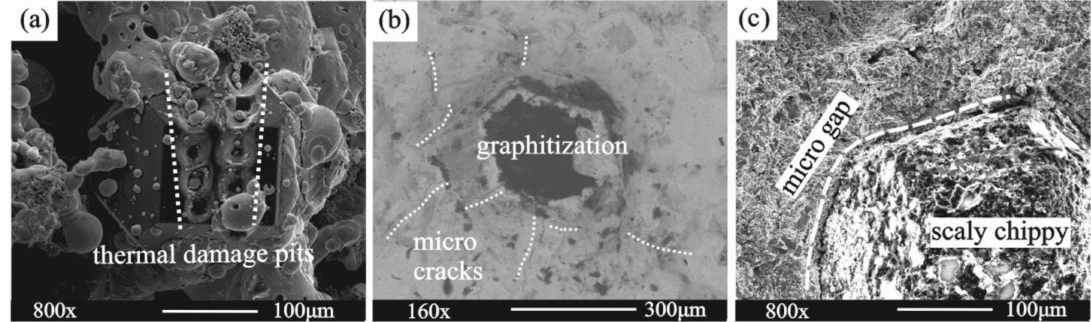
Figure 4. SEM images showing the e ff ects of manufacturing methods on diamond thermal damage: ( a ) SLM; ( b ) vacuum brazing; ( c ) hot-pressing